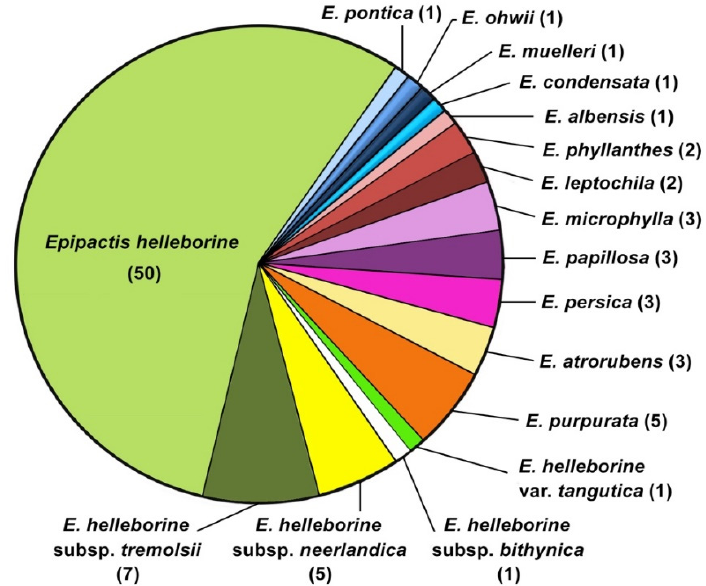
Figure 2. The current status of names of infraspecific taxa published in Epipactis helleborine , based on [73–76]. The number of names synonymised with E. helleborine s.l. and to other species is shown in parentheses.